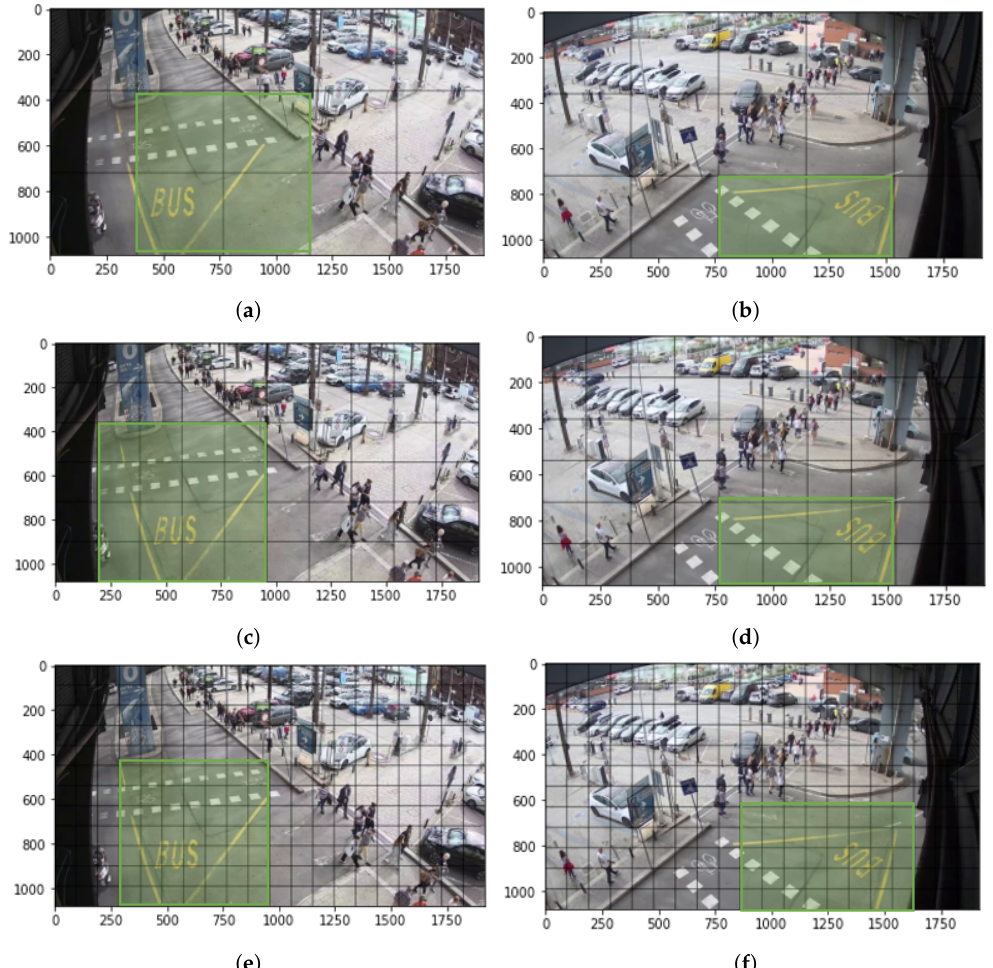
Figure 2. Regions of interest (ROIs) inside the monitored area (green rectangles), for each considered SSD output grid on TLC1 (left column) and TLC2 (right column). ( a ) ROI on TLC1 for output grid of size 3 × 5. ( b ) ROI on TLC2 for output grid of size 3 × 5. ( c ) ROI on TLC1 for output grid of size 6 × 10. ( d ) ROI on TLC2 for output grid of size 6 × 10. ( e ) ROI on TLC1 for output grid of size 12 × 20. ( f ) ROI on TLC2 for output grid of size 12 ×